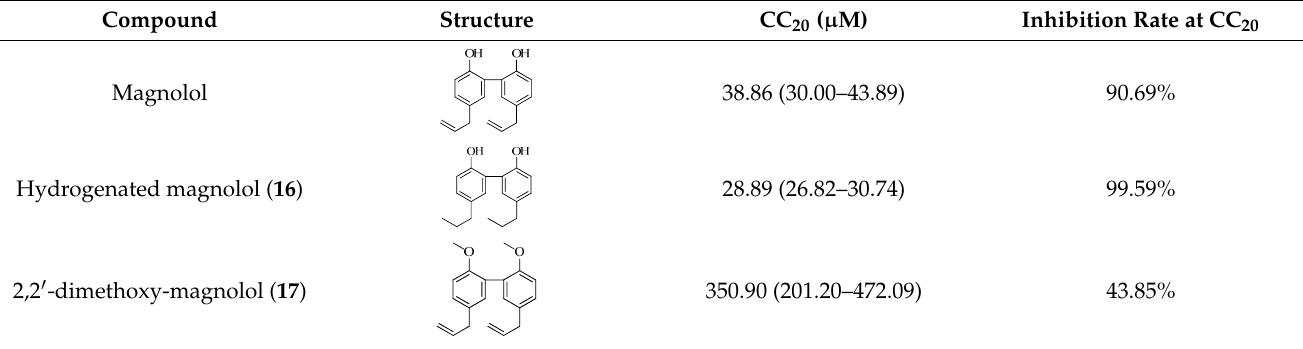
Figure 4. Dose–dependent effect of magnolol ( A ) and hydrogenated magnolol ( B ) against MSRV. The half–maximal inhibitory concentration (IC 50 ) is marked. The error bar indicates the SEM.